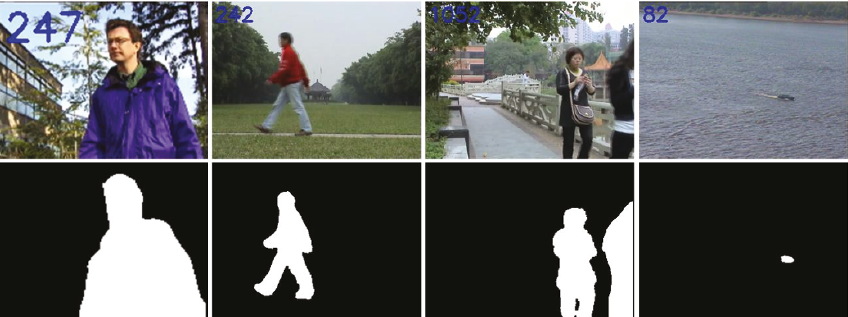
Figure 9: Some detection results by our method. The first row contains the original video frames. The second row contains the corresponding detection